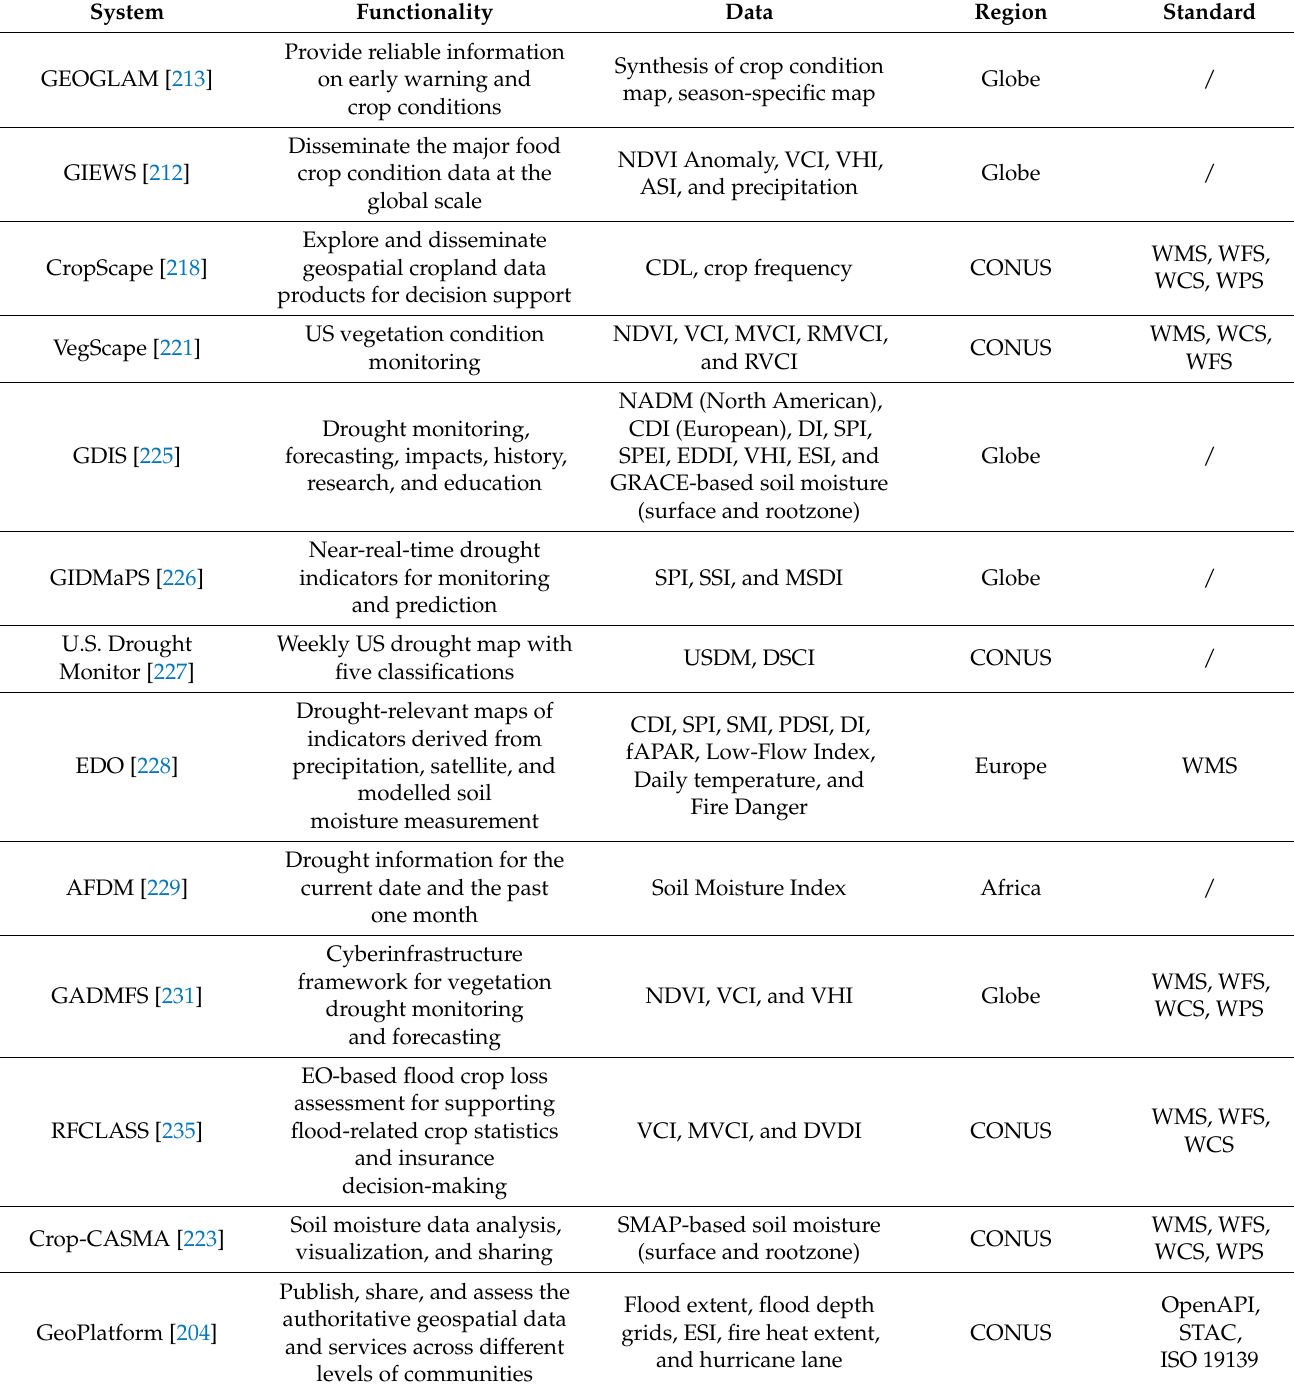
Table 1. Summary of typical studies of agricultural disaster services and